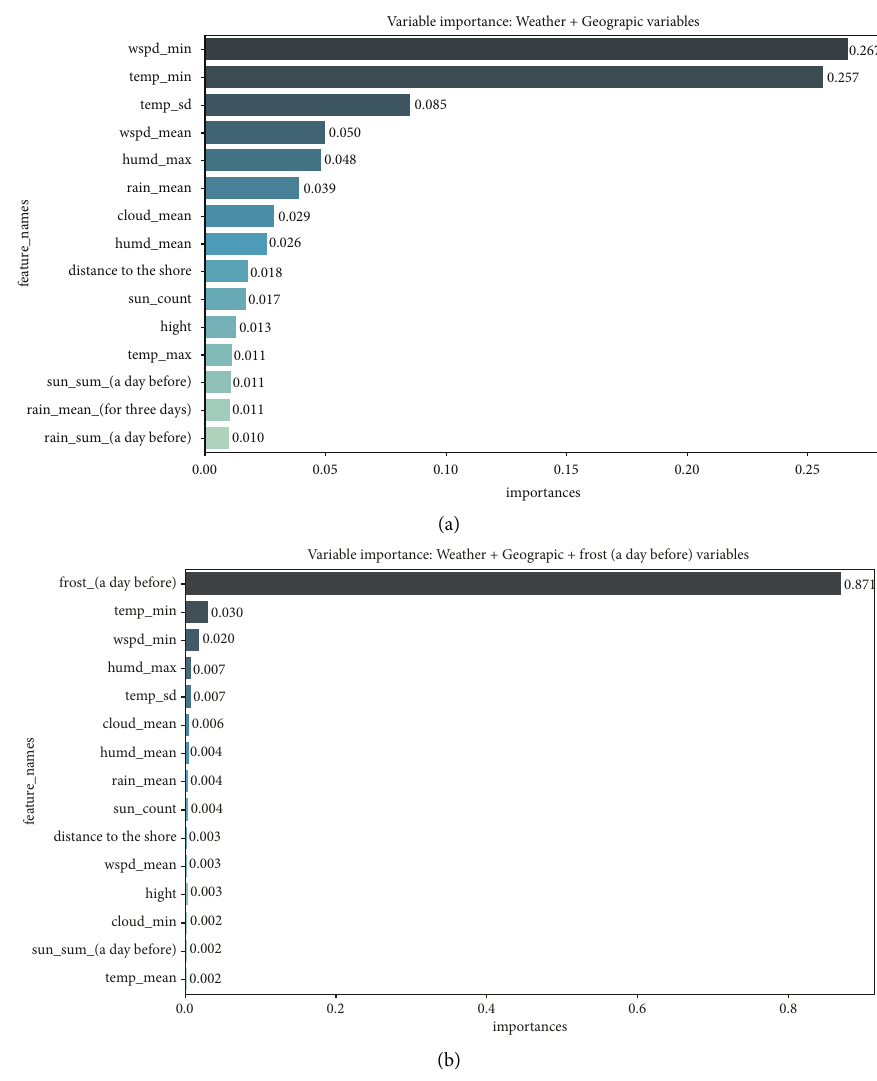
Figure 6: (a) Variable importance of weather and geographic variables in the XGBoost model and (b) variable importance of weather, geographic, and frost (a day before) variables in the XGBoost model.